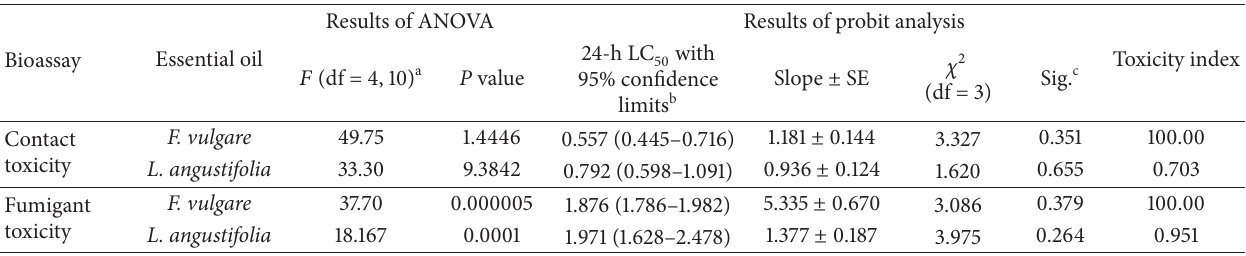
Table 2: Contact and fumigant toxicity of the essential oils isolated from Foeniculum vulgare and Lavandula angustifolia against the adult females of Tetranychus urticae